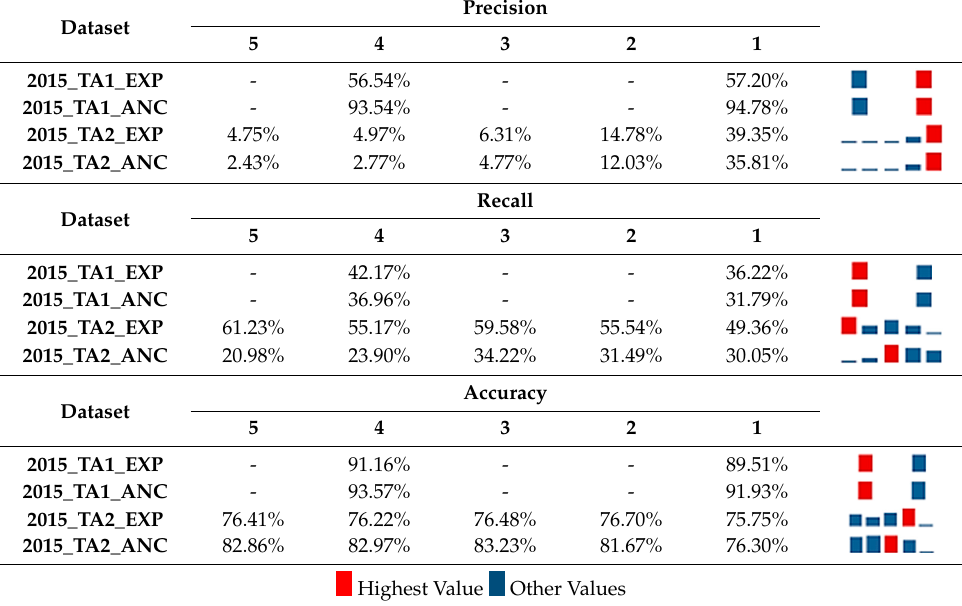
Table 5. Accuracy values (i.e., precision, recall and accuracy) of classification results for the first and second area, two scenarios and different degrees of agreement.